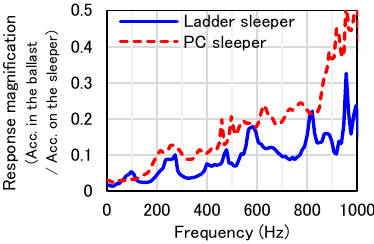
Figure 9. Comparison of the response magnification of the ladder sleeper and PC sleeper.